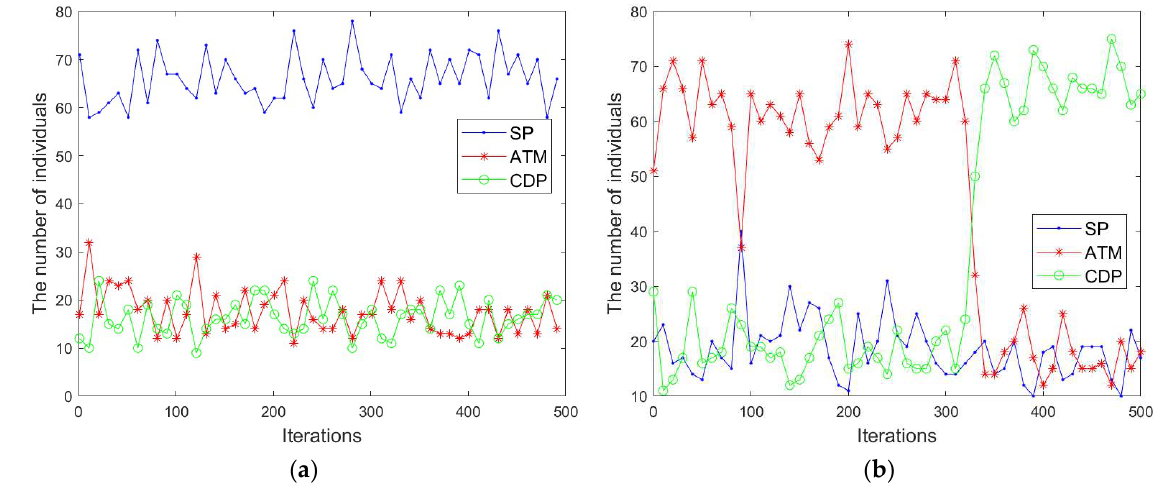
Figure 2. The number of individuals of CHTs changes during the whole evolutionary process. ( a ) CH6, ( b ) NCTP11. Table 12. IGD and HV results of three variants on CF6 and NCTP11.